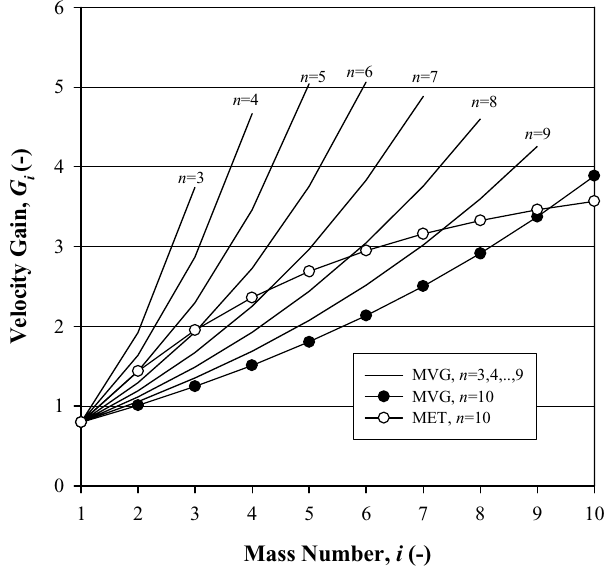
Mass Number, i (-) Fig. 16. Plot comparing vertically-stacked MVG systems (from three to ten masses) and the optimal ten-mass MET system for e = 0 . 8 and R = 0 . 012 . In each system the velocity gain is plotted for every mass (i.e., velocity gain of every mass just after impact with a mass below it) to highlight its sequential growth. (-) means